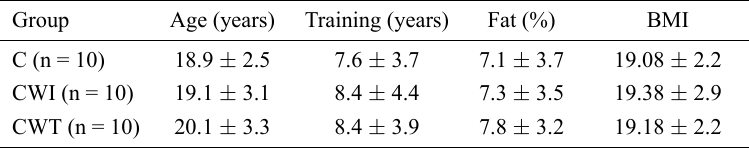
Table 1. Comparison of participant characteristics.